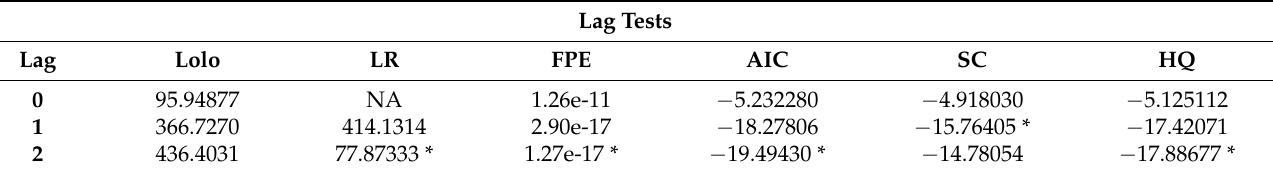
Table 3. Var lag length selection criteria.